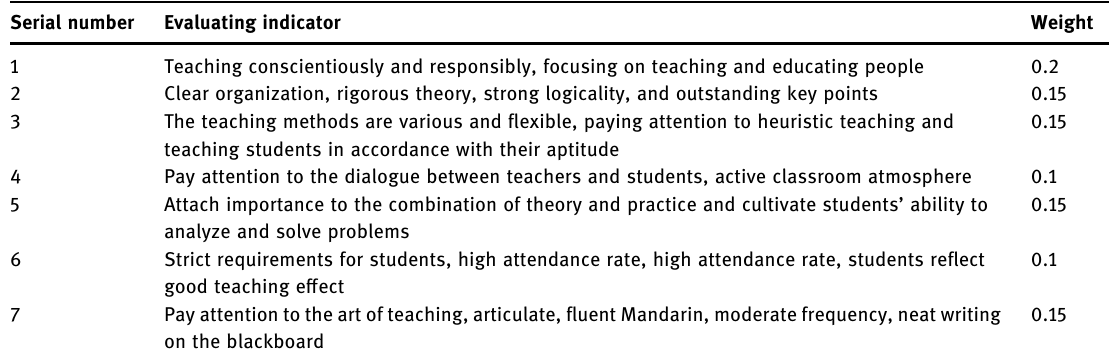
Table 5: Expert evaluation index and weight coe ffi cient Serial number